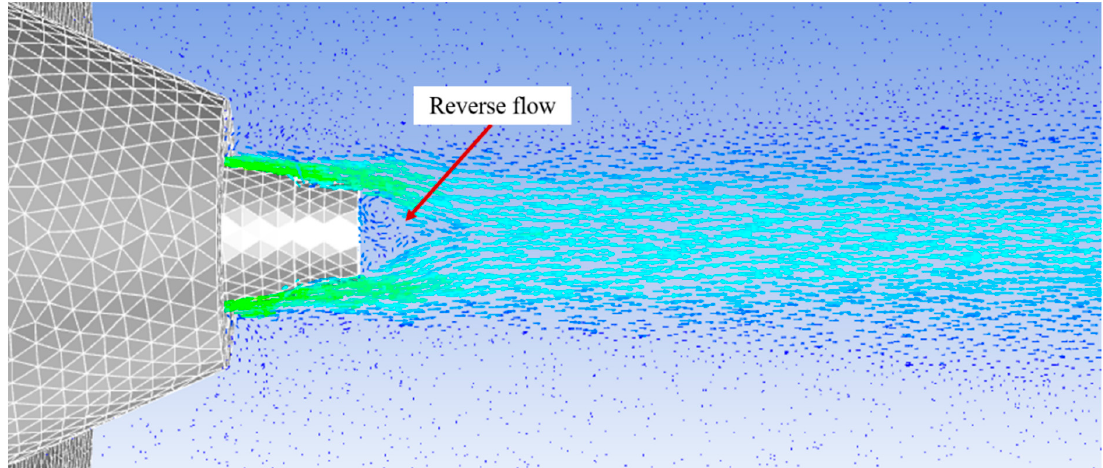
Figure 5. Reverse flow in the vicinity of the polymer solution syringe tip that can choke the syringe.